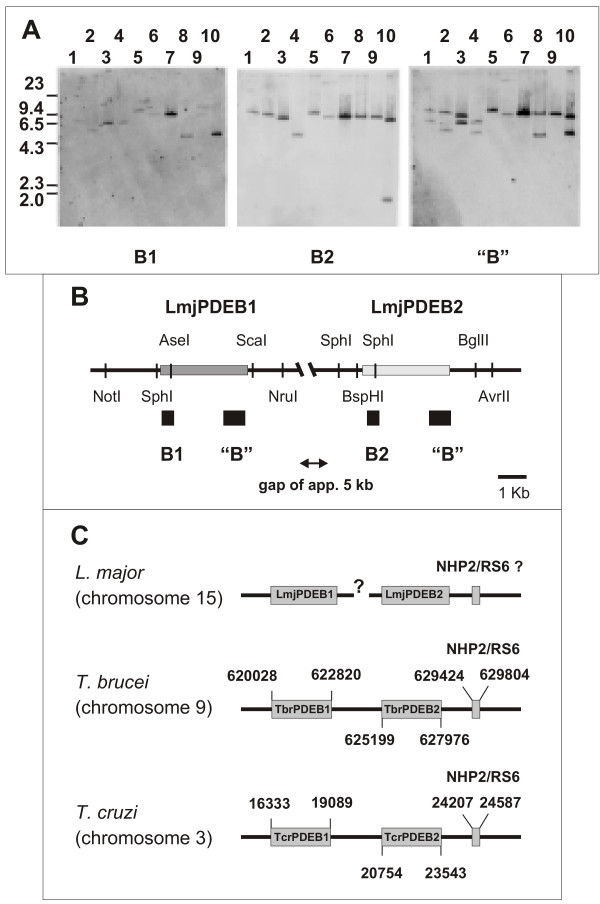
Genomic organization of PDE genes. Panel A: Southern blot analysis. Genomic DNA of L. major was digested with BspHI (lane 1), BspHI plus ScaI (lane 2), BspHI plus NruI (lane 3), BspHI plus AvrII (lane 4), NotI (lane 5), NotI plus BglII (lane 6), NotI plus AvrII (lane 7), NotI plus ScaI (lane 8), AseI (lane 9) and SphI (lane 10). The blots was hybridized with probes B1 and B2 that specifically recognize LmjPDEB1 or LmjPDEB2, respectively (see panel B), or with probe "B" that hybridizes to both genes. The sizes of the DNA size markers are given on the left. Panel B: Organization of the LmPDEB locus on chromosome 15. Restriction sites used in the mapping are indicated. The uncharacterized stretch between the two coding regions is estimated to be about 5 kb long. Filled boxes labelled B1, B2 and "B" indicate the gene regions used as hybridization probes. Panel C: Genomic organization of the LmjPDEB1/LmjPDEB2 locus on chromosome 15 of L. major. The organization of the corresponding loci of T. brucei and T. cruzi are given for comparison. T. brucei: TbrPDEB1 (old designation: TbPDE2C; Tb09.160.3590) and TbrPBEB2 (old designation TbPDE2B; Tb09.160.3630) and NHP/2RS6 (Tb09.160.3670). T. cruzi: TcrPDEB1 (Tc00.1047053508277.100) followed by TcrPDEB2 (old designation TbPDE1; Tc00.104053508277.120; GenBank accession number AAP49573) and by NHP2/RS6 (Tc00.104053508277.120). Numbers indicated nucleotide positions on the respective chromosomes.